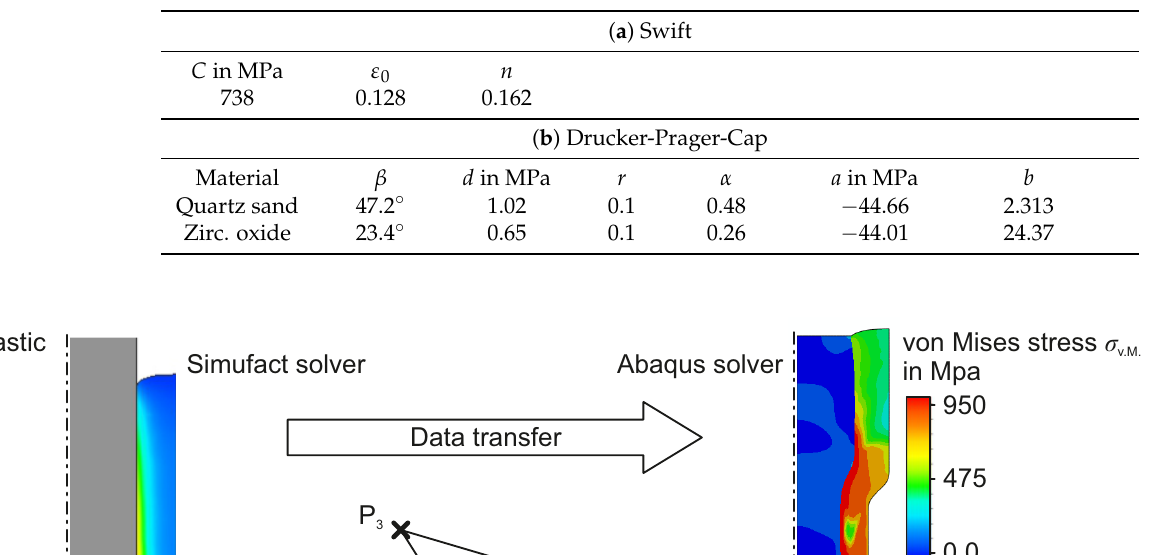
Table 3. Material parameters for ( a ) C15 steel, identified by Kolpak [18], and ( b ) granular media, identified by Chen [20].